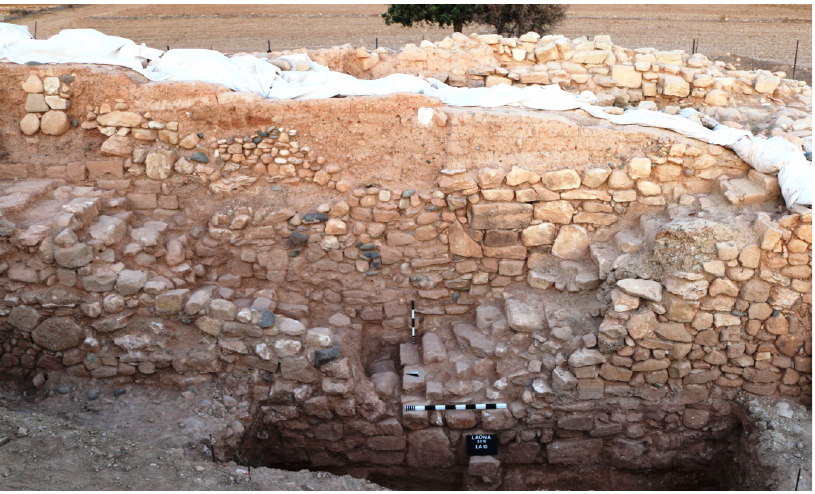
Figure 22. Facing staircases of the Laona fortress. Photo by author (PULP@).